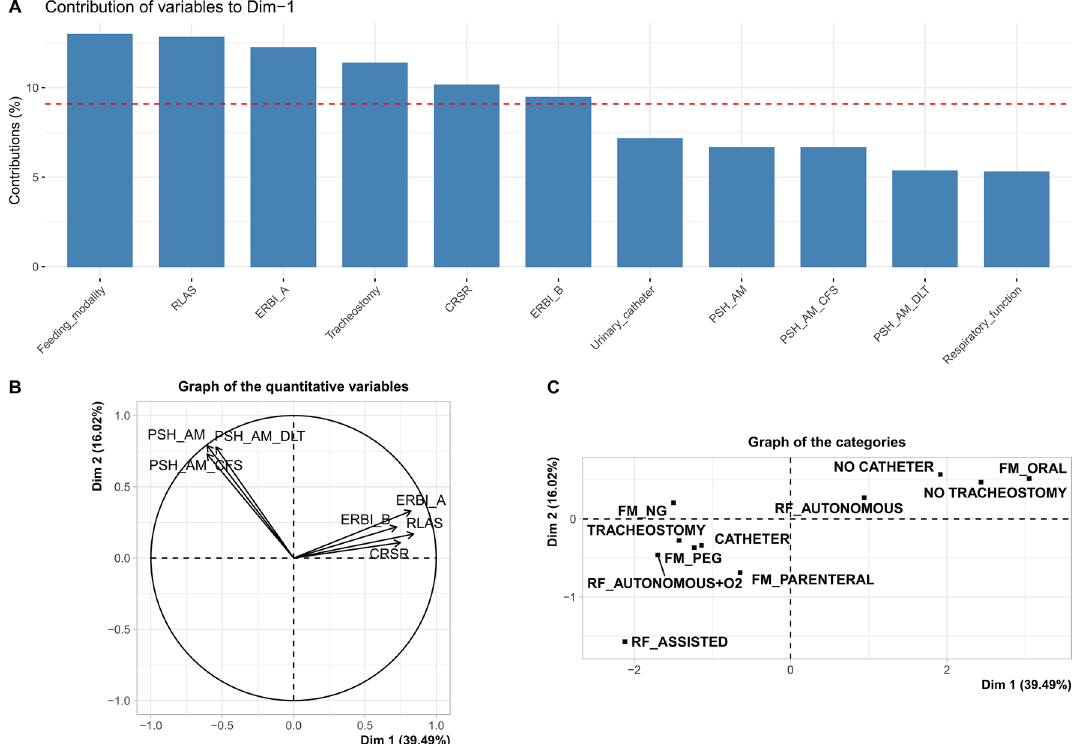
Figure 1. Panel ( A ) Contributions, in percentage terms, of each predictor to the first dimension from the principal component analysis. Panel ( B ) Plot of the loading vectors (coefficients of the variables on the principal components) for quantitative predictors. Panel ( C ) Plot of the coefficients of the variables on the principal components for qualitative